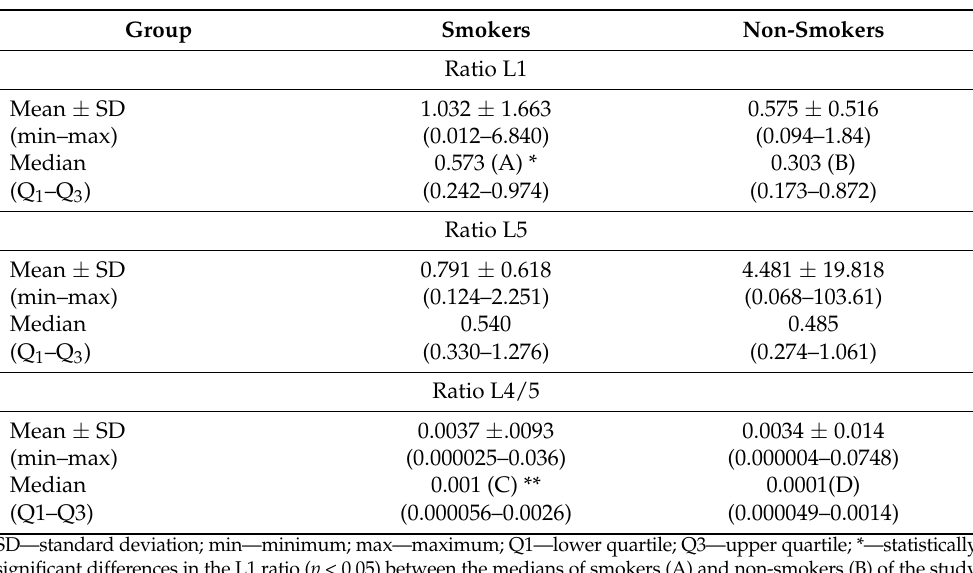
Table 7. Fat/water ratio of selected spine structures in 1 H-MRS in people with osteoarthritis of the spine disease depending on cigarette smoking.